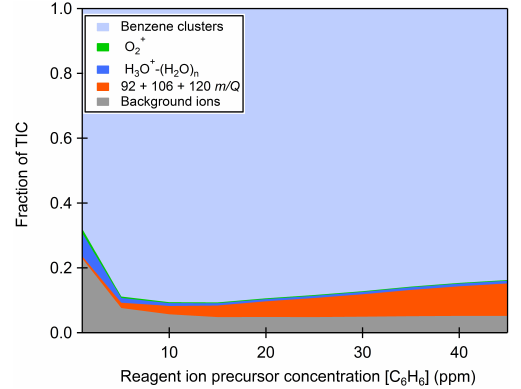
Figure 2. Partitioning of total ion current (TIC) on the CI-ToFMS between benzene clusters (light blue), O + (green), water clusters 2 (dark blue, n = 0 to 3), and background peaks (orange and gray) as a function of benzene reagent-ion concentration at <1% rela- tive humidity. Molecules corresponding to 92, 106, and 120 m/Q are attributed to alkyl-substituted benzene molecules: C 6 H 5 -CH + , 3 C 6 H 4 -(CH 3 ) + , and C 6 H 4 -(CH 3 ) + , 2 3